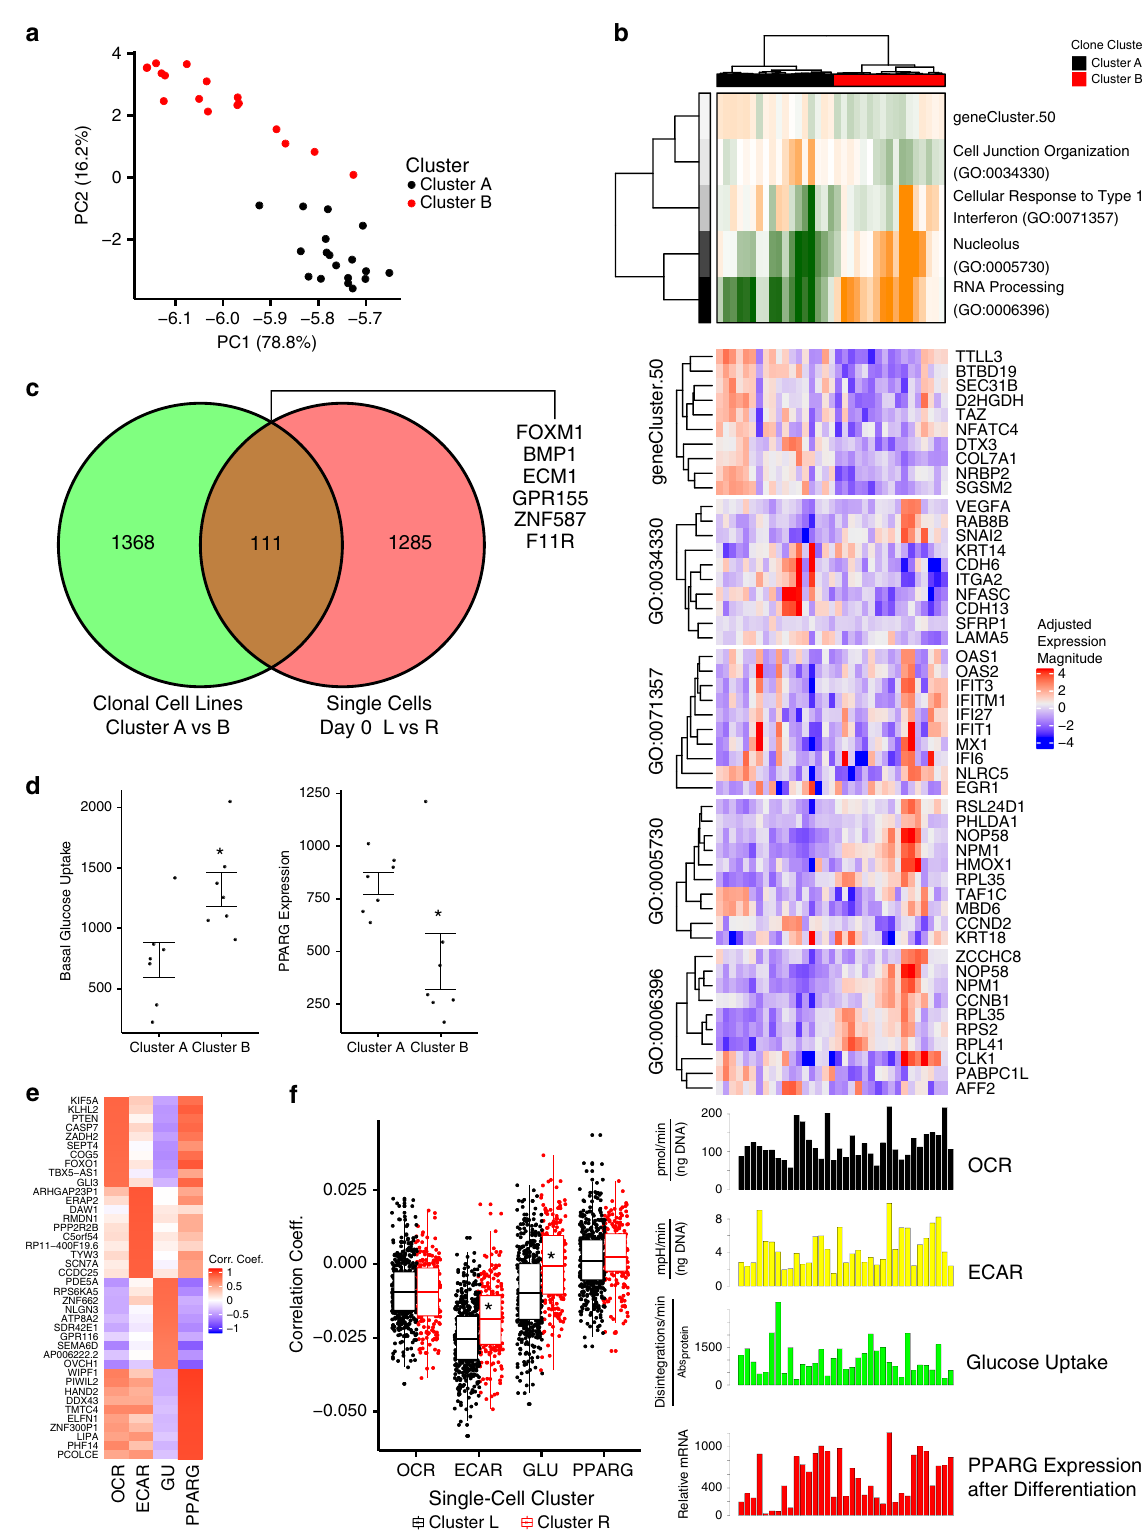
phenotype correlations were projected to the single-cell data to determine whether any gene signatures would preferentially mark the heterogeneous populations of single cells. The results indicated that the clusters showed differences in the expression of genes correlated to extracellular acidi fi cation and glucose uptake across multiple days (Fig. 2f, Supplementary Fig. 5A –